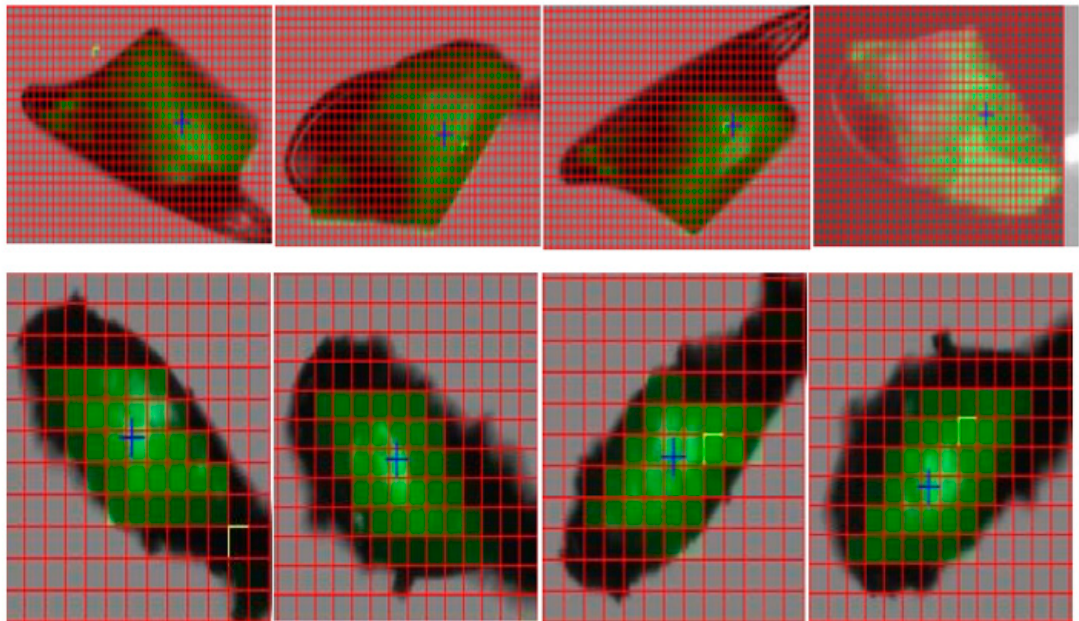
Figure 15. “Raster scans” from thaumatin crystals grown in agarose capillary pipettes; top panel crystals grown as control, bottom panel NMR-bp grown crystals; images shown from left to right were taken in 90 degrees steps. Control crystals show a large area without diffraction, dark area, while NMR-bp grown crystals show uniform illumination.